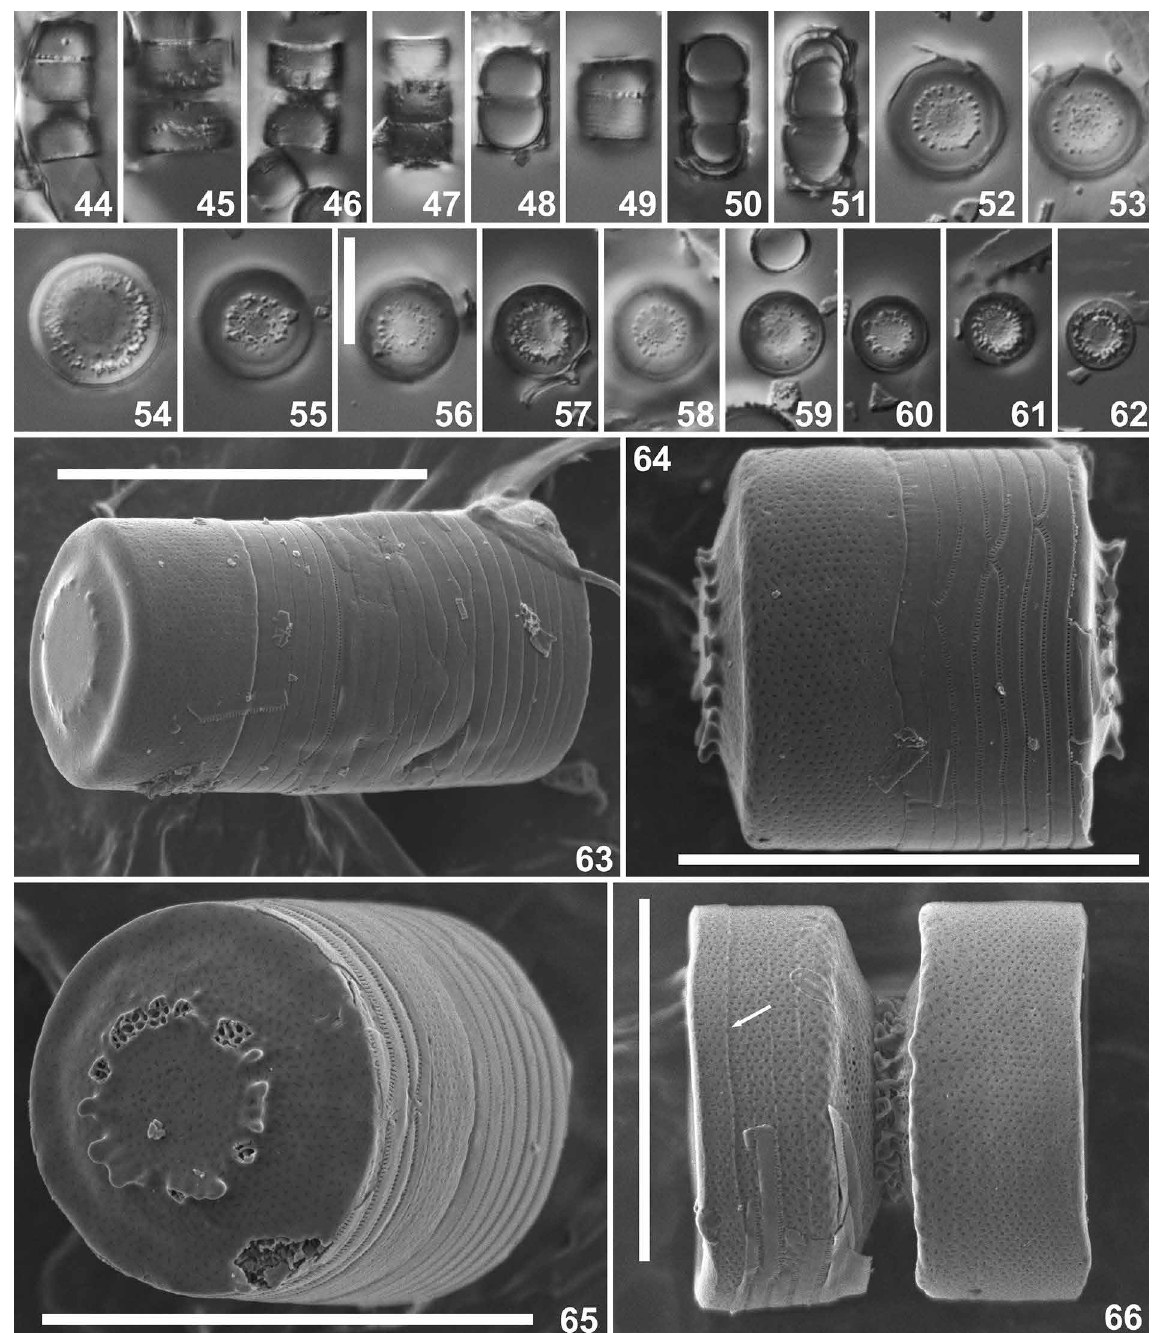
Figs 44–66. Ferocia houkiana Goeyers & Van de Vijver sp. nov. LM and SEM. Campbell Island holotype population, sample BAS284 (BR-4578). LM. 44–49 . Several frustules in girdle view, often connected to each other. 50–51 . Internal valves. 52–62 . Several valves in valve face view clearly showing the central ring of spines. SEM. 63 . Frustule in girdle view with the narrow copulae. 64 . Frustule in girdle view with the narrow copulae on one side and one the side showing the broad mantle with one indicated rimoportula. 65 . External view of a valve face and the girdle. Note the central ring of partly hollow spines. 66 . External view of two valves connected via their linking spines. The arrow indicates the Müller step. Scale bars = 10